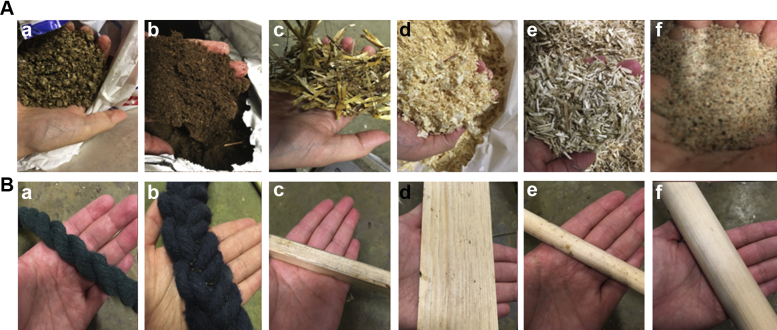
(A) The 6 tested litter types: (a) crushed straw pellets (RS MUSTANG, Enköping, SE), (b) peat (RS MUSTANG, Enköping, SE), (c) straw (Smådjurshalm LUPUS, Granngården Uppsala, SE), (d) wood shavings (Kutterspån GRANNGÅRDEN, Uppsala, SE), (e) hemp shavings (Lättströ GRANNGÅRDEN, Uppsala, SE), and (f) fine-grained sand (0–0.03 mm, RÅDASAND, Djur-Hobby Uppsala, SE). (B) The 6 tested perch types: (a) narrow rope (1.8 cm in diameter), (b) wide rope consisting of 3 narrow ropes braided together (4.5 cm in diameter), (c) narrow flat wood (1.5 × 1.5 cm), (d) wide flat wood (6.7 × 0.8 cm), (e) narrow round wood (1.5 cm in diameter), and (f) wide round wood (3.5 cm in diameter).